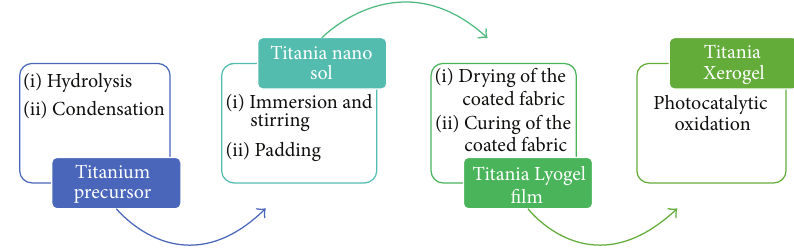
Figure 3: Stages of titanium nanoparticles with processes from precursor to coated fabric.